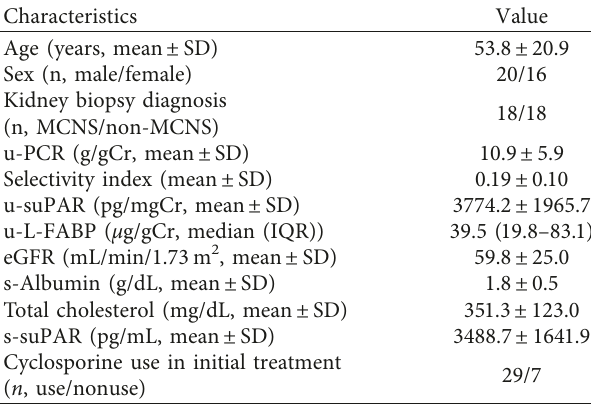
Table 1: Baseline patient